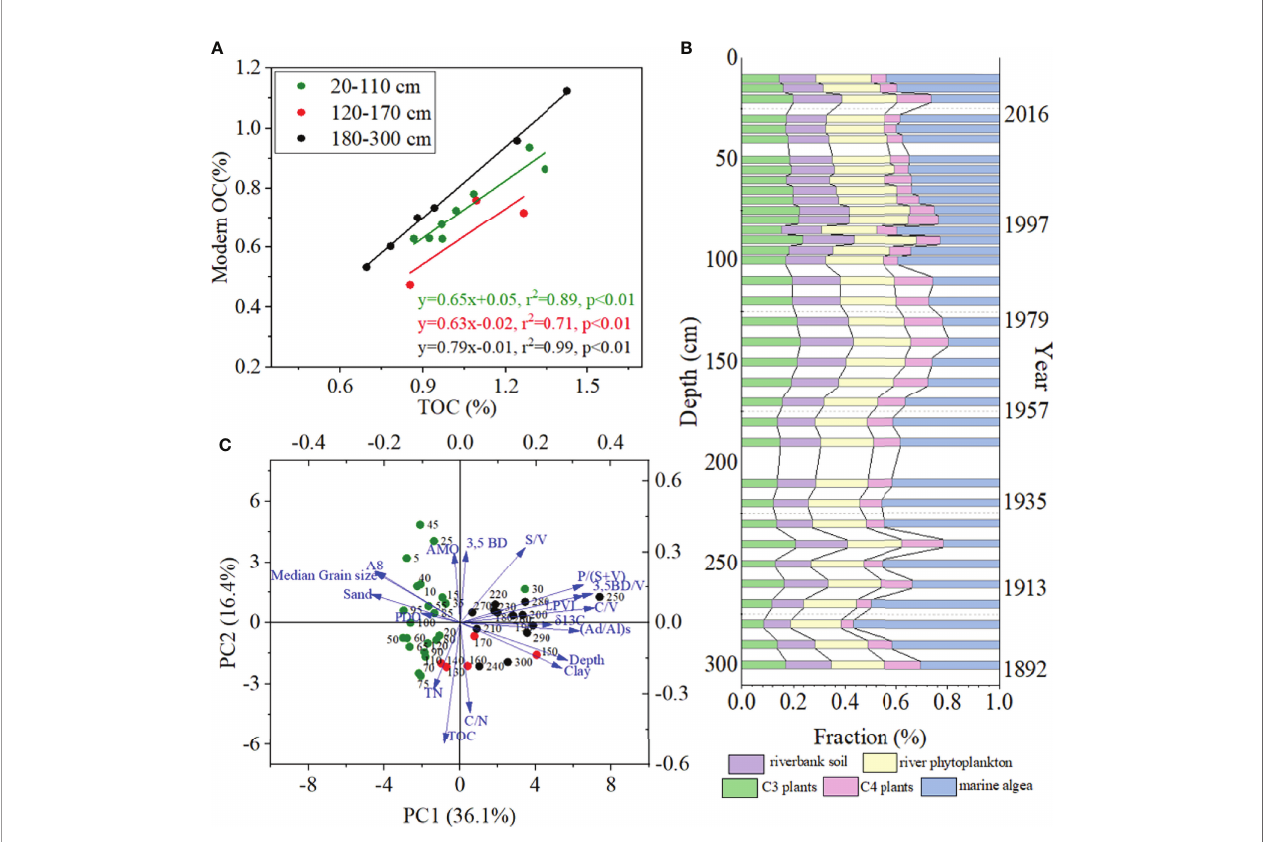
FIGURE 5 | (A) A binary plot used to determine OC petro concentration in bulk sediments by plotting Fm of bulk TOC ×TOC (%) vs. TOC (%). The solid lines represented the best linear fi t of the three periods. The slope represented the fraction of modern value of biospheric OC (Fm bio ), while the intercept on x-axis represented the content of petrogenic OC (OC petro ) in sediments. (B) Fraction of OC sources from fi ve end-members based on Monte Carlo simulation of the PRE sediment core. (C) Principal component analyses of parameters in this study. TABLE 1 | Historical changes of Fm bio , OC petro (%), OC bio (%), and OC bio /OC (%) in the PRE sediment. Depth (cm) Stage Fm bio